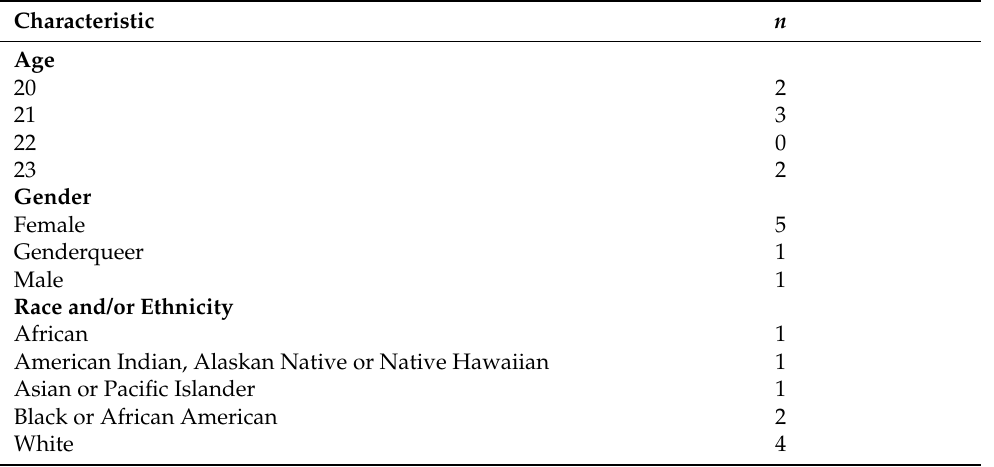
Table 1. Demographic characteristics of Step 1 sample ( N =